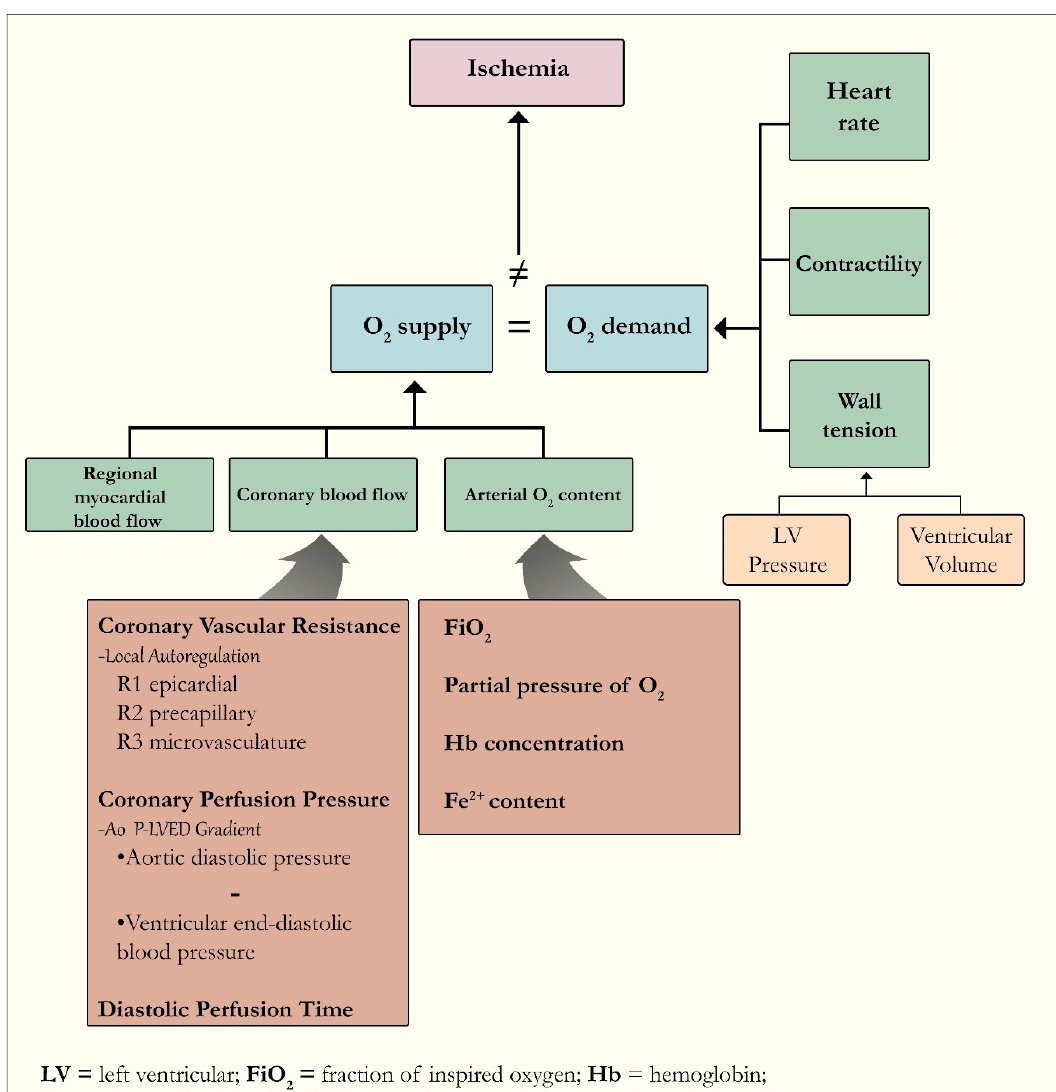
Figure 1. The relationship between myocardial oxygen supply and demand.